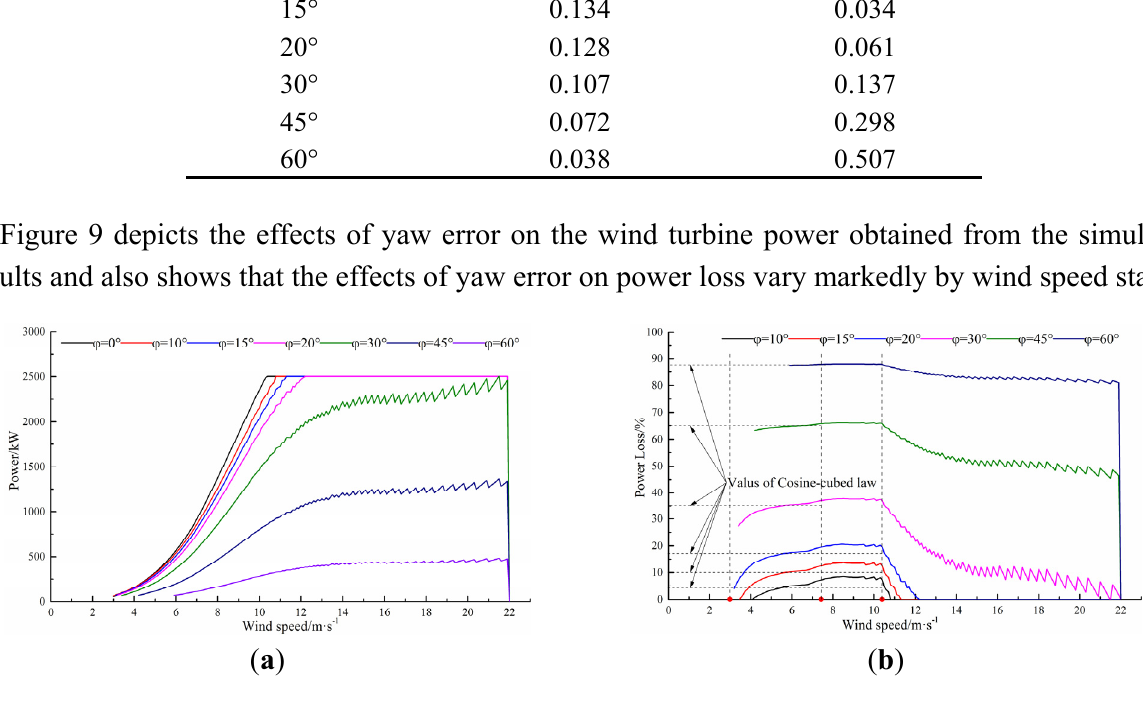
Figure 9. Effects of yaw error on the wind turbine power. ( a ) Wind turbine power curve; ( b ) Power loss